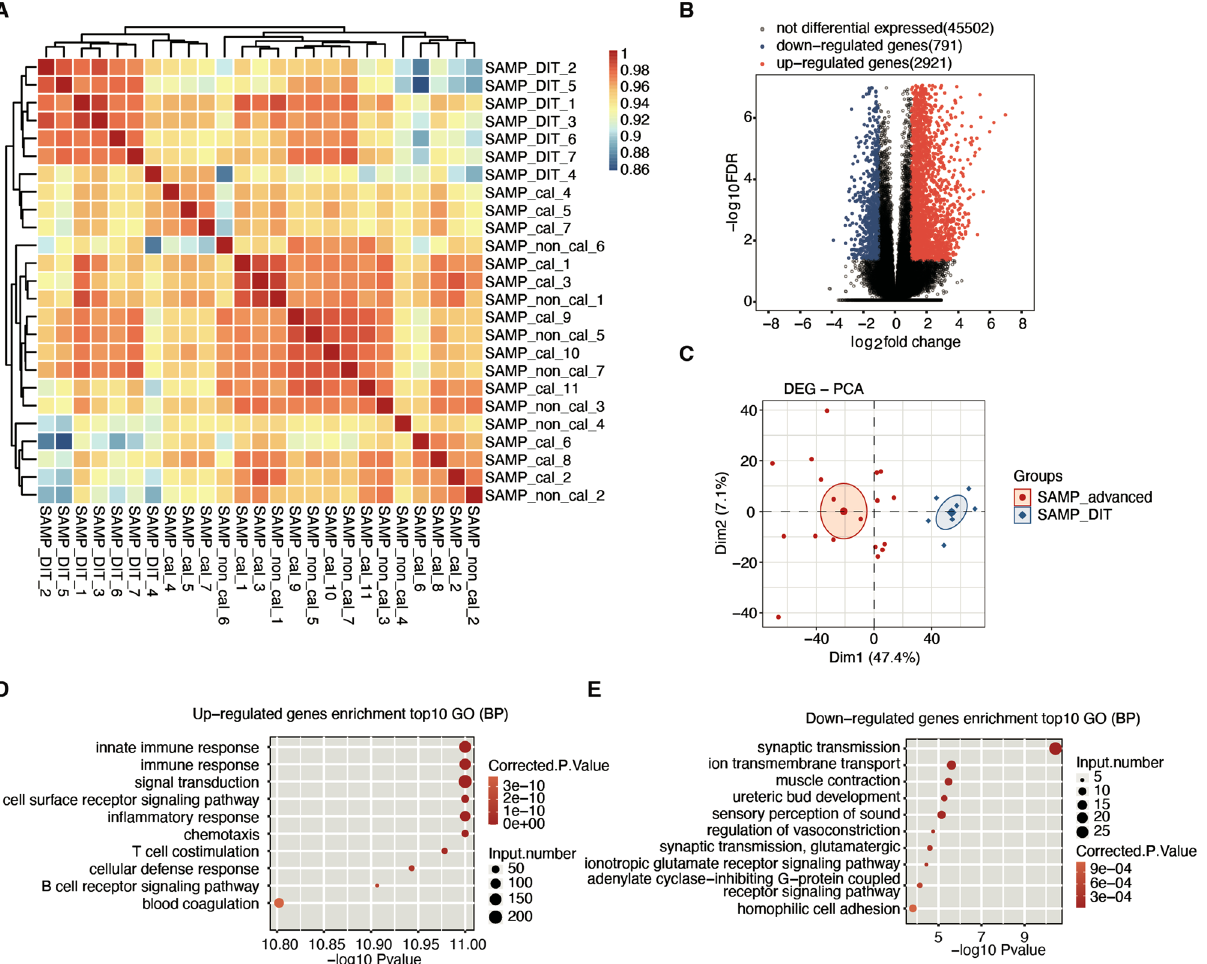
Figure 1. Transcriptome analysis of DEGs in atherosclerotic plaques in the early disease stage (SAMP_DIT) and advanced disease stages (SAMP_advanced). ( A ) Sample correlation between SAMP_DIT and SAMP_ advanced (SAMP_cal and SAMP_non_cal) samples.The heatmap scale represent correlation coefficient between different samples. ( B ) Volcano plot displaying DEGs in each group compared to the SAMP_DIT samples. Red indicates genes with upregulated expression (FC ≧ 2 and FDR ≦ 0.05). Blue indicates genes with downregulated expression (FC ≦ 0.5 and FDR ≦ 0.05). ( C ) Principal component analysis (PCA) of 18 SAMP_advanced and 7 SAMP_DIT samples after normalizing all known DEG expression levels. The samples were grouped by left and right atrial appendages and atherosclerotic stage, and the ellipse for each group is a confidence ellipse. ( D , E ) GO analysis of DE mRNAs, divided into genes with up- ( D ) and down-regulated ( E )